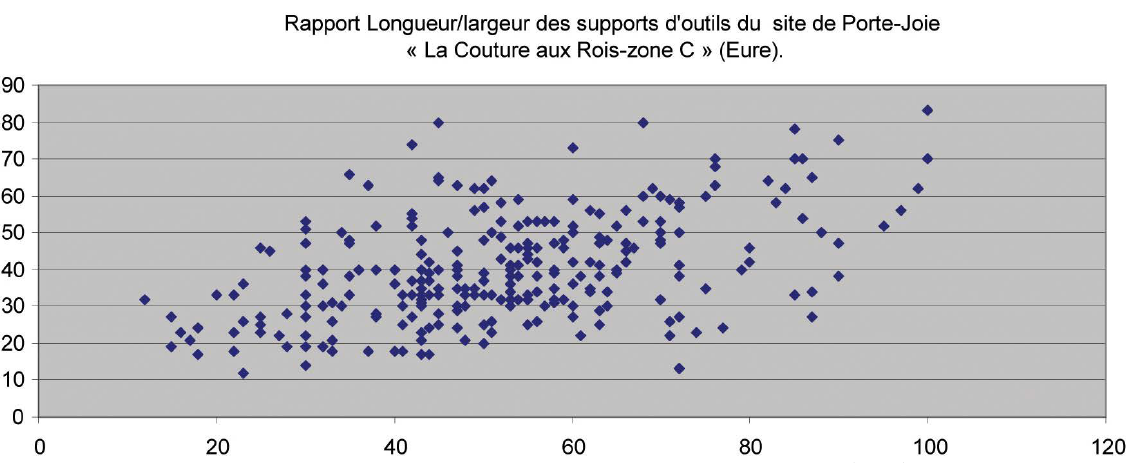
Figure 7. Rapport Longueur:largeur des supports d'outils du site de Porte-Joie (Eure). Axe des abscisses : Longueur en mm, axe des ordonnées : largueur en mm . 265 individus. Figure 7. Length:width ratio of tool blanks of the Porte-Joie site (Eure). X axis: Length in mm, ordinate axis: width in mm. 265